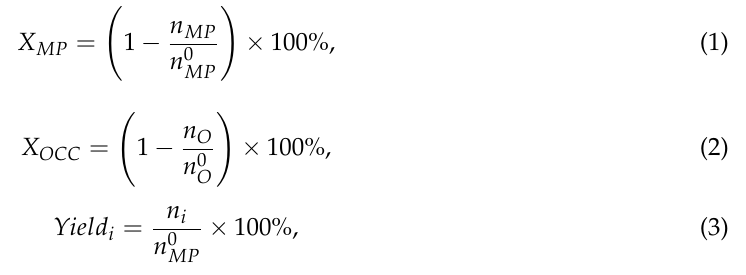
Figure S1: TEM image of Ni 2 P/SiO 2 catalyst reduced ex situ, Figure S2: GC FID calibration graph of methyl palmitate, Figure S3: GC FID calibration graph of palmitic acid, Figure S4: GC FID calibration graph of n -pentadecane, Figure S5: GC FID calibration graph of n